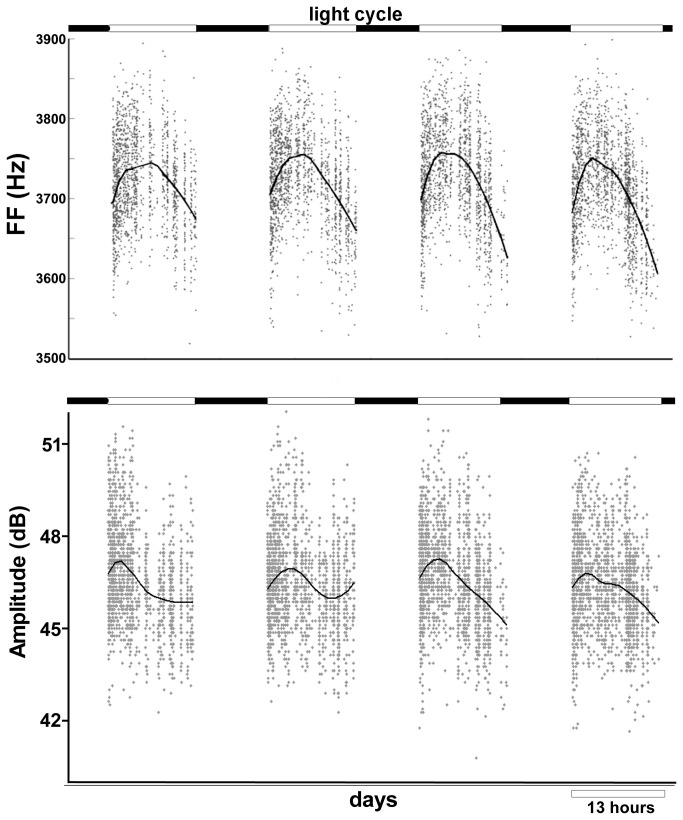
Syllable FF and amplitude follow a daily oscillation.
A) The FF for 1 syllable across 4 days of singing, each point represents one rendition of the syllable. The black lines are RLOESS fits. B) The amplitude for the same syllable and same renditions as in A.